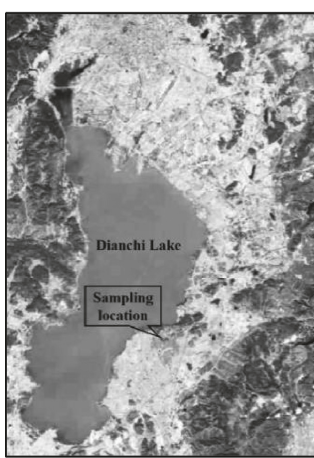
Figure 3: Location of soil layer for test